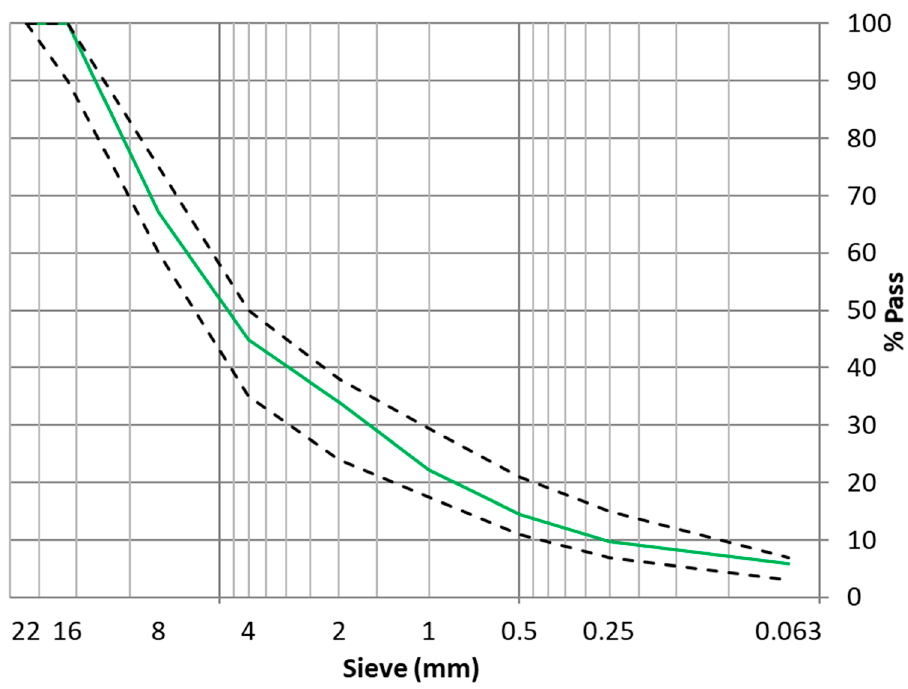
Figure 4. Particle size distribution in AC mixture.